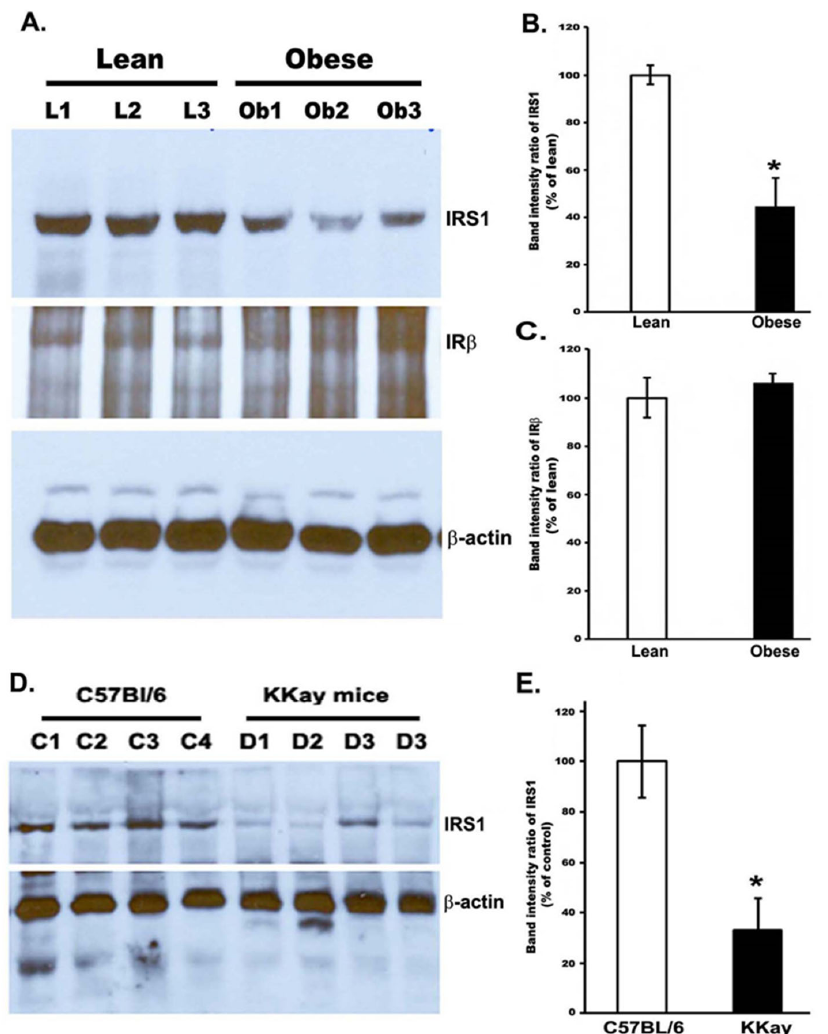
Figure 2. Expression of IRS-1 and IR β protein in the gastrocnemius muscle of Zucker rats and KKay mice. Protein was isolated from the muscle as described in the Methods section. ( A ). The amount of IRS-1 protein was determined by immunoblotting with anti-IRS-1 and anti-IR β antibodies (N = 6). Band intensity was quantitated with a Bio-Rad Molecular Imager. ( B ). Band intensity of IRS1 in obese rats in terms of % of control (lean rats). ( C ). Band intensity of IR β in terms of % of control (lean rats). ( D ). Expression of IRS1 in the gastrocnemius muscle of KKay and C57BL/6 mice (N = 4). ( E ). Band intensity of IRS1 in KKay mice in terms of % of control (non-diabetic C57BL/6 mice). * p < 0.01; vs. Zucker lean rats.